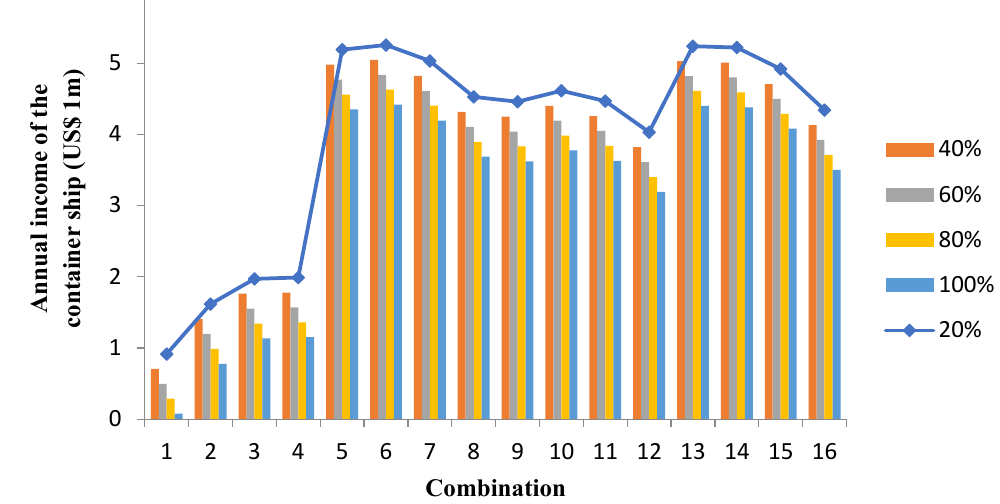
Figure 3. Annual income of the container ship with different combinations of CO 2 emission reduction measures in 2060.